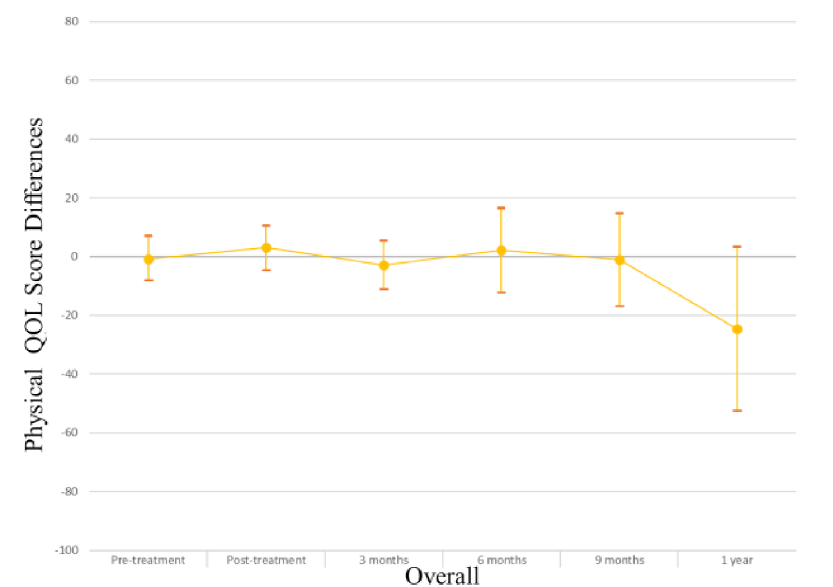
Figure 4. Physical QOL score differences in overall study population.